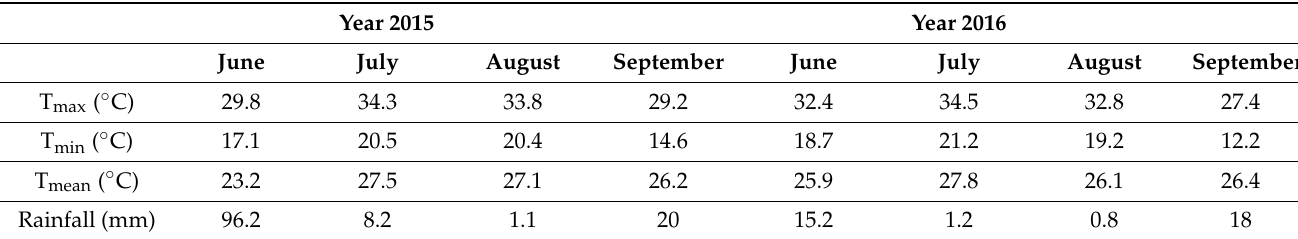
Table 3. The main weather parameters (Rainfall, maximum (T max ), minimum (T min ), and mean (T mean ) temperature), for the two years. The weather data were recorded with an automatic weather station close to the experimental site.